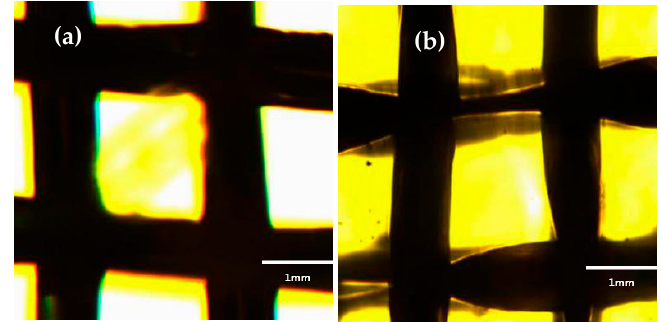
Figure 1. Copper mesh morphology under fluorescence microscope. ( a ) Untreated copper mesh; ( b ) Etching and oxidation copper mesh.